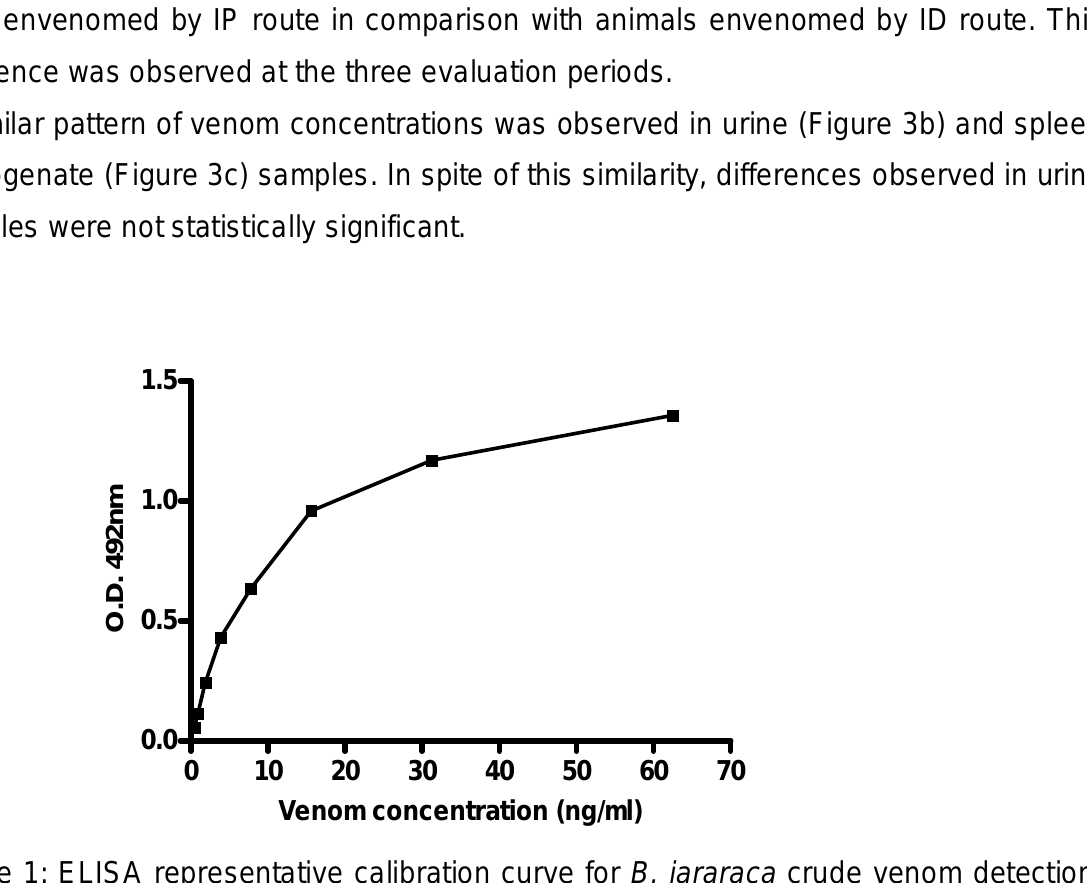
Figure 1: ELISA representative calibration curve for B. jararaca crude venom detection. Venom was diluted with PBS/milk 3% and ELISA developed with the reagents described before. Resulting optical densities were correlated to venom concentrations. Optical densities from three separate assays were combined (n=6) and showed in mean ± SD. The r value is